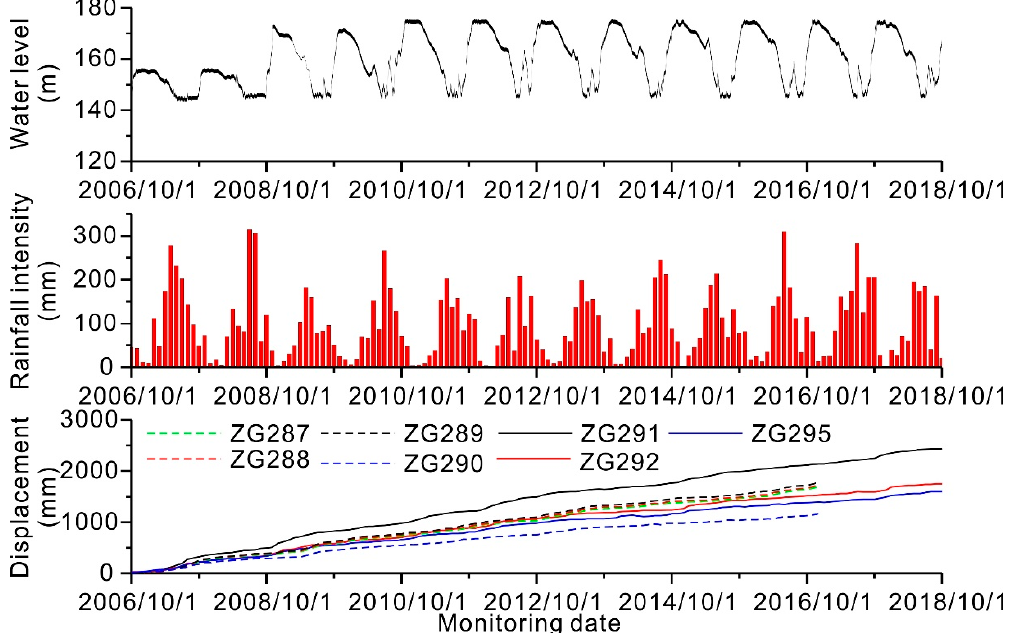
Figure 5. Reservoir water level, monthly rainfall intensity, and cumulative displacement from the Fanjiaping landslide area.